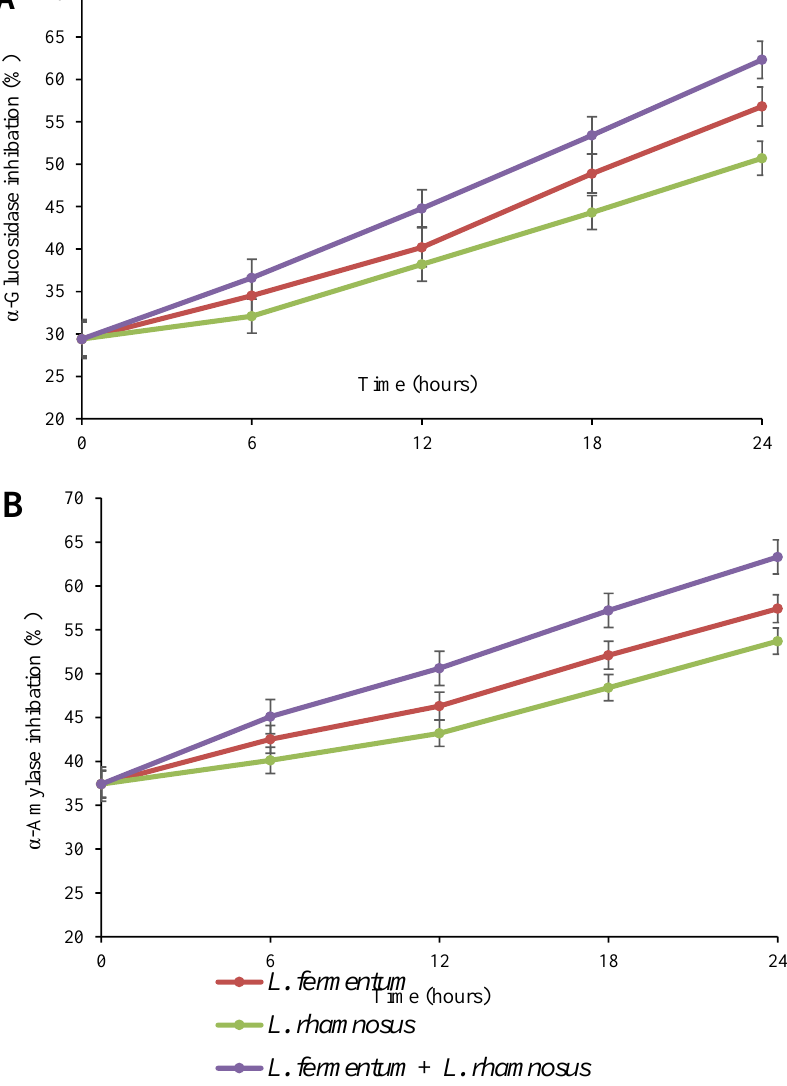
Figure 6. α -Glucosidase ( A ) and α -amylase ( B ) inhibitions of quinoa seed fermented by pure and binary mixed cultures of two Lactobacillus species. The error bars reveal the standard deviation of each measurement in quinoa seed over 24 h of fermentation. L. rhamnosus : Lacticaseibacillus rhamnosus monoculture; L. fermentum : Limosilactobacillus fermentum monoculture; L. rhamnosus + L. fermentum : binary co-cultures of L. rhamnosus and L. fermentum.